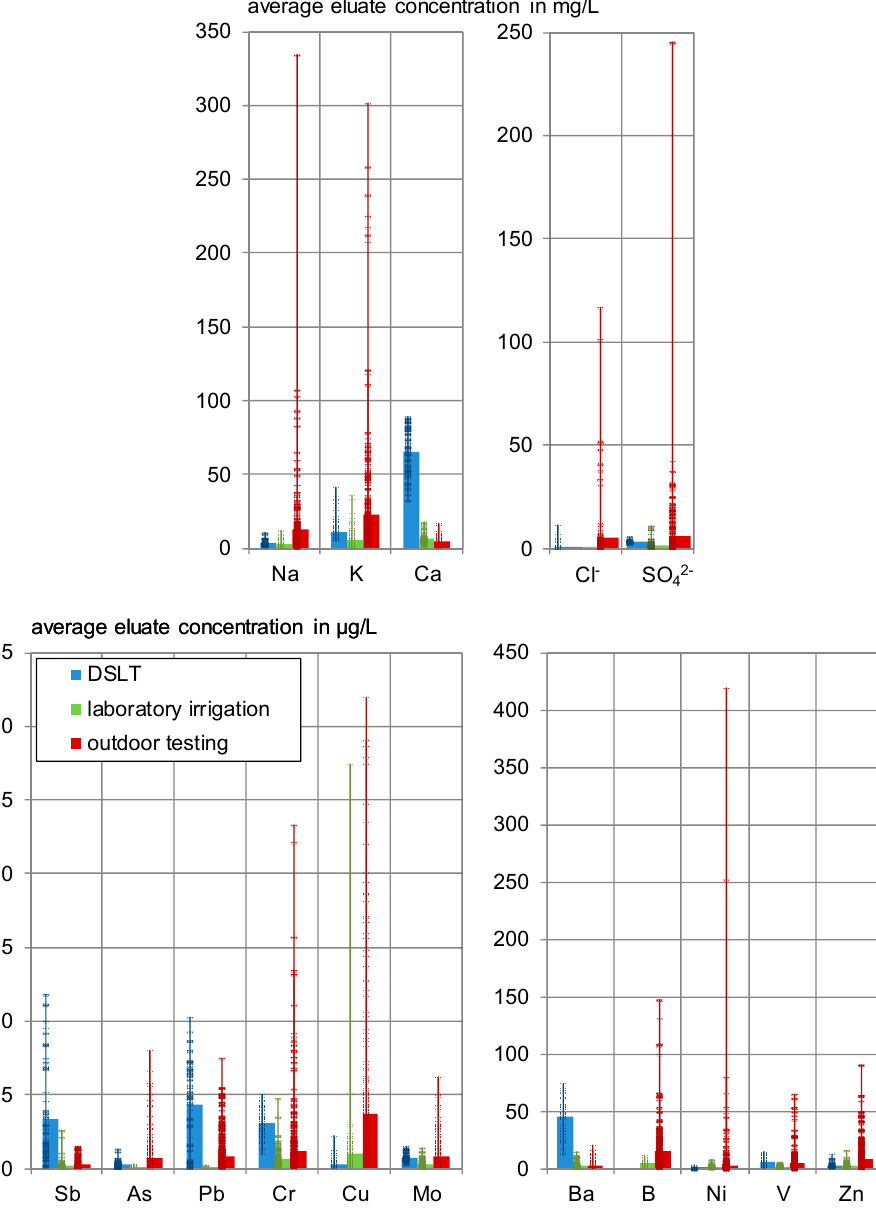
Figure 13. Average eluate concentrations and value distribution of DSLT, laboratory irrigation, and outdoor testing.